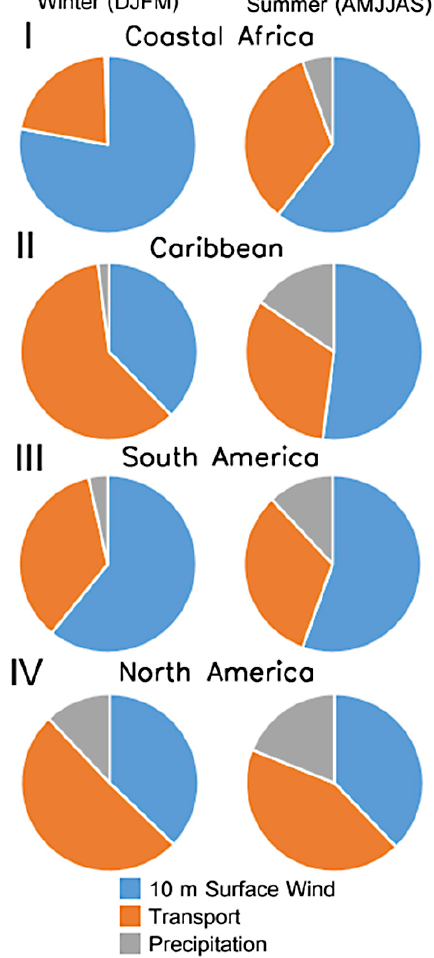
Figure 5. Attribution of the interannual variability in dust is shown for the four regions in Fig. 2. The approximate fraction of the variability owing to 10m surface winds (blue), transport (orange) and precipitation (gray) is displayed for winter (left) and summer